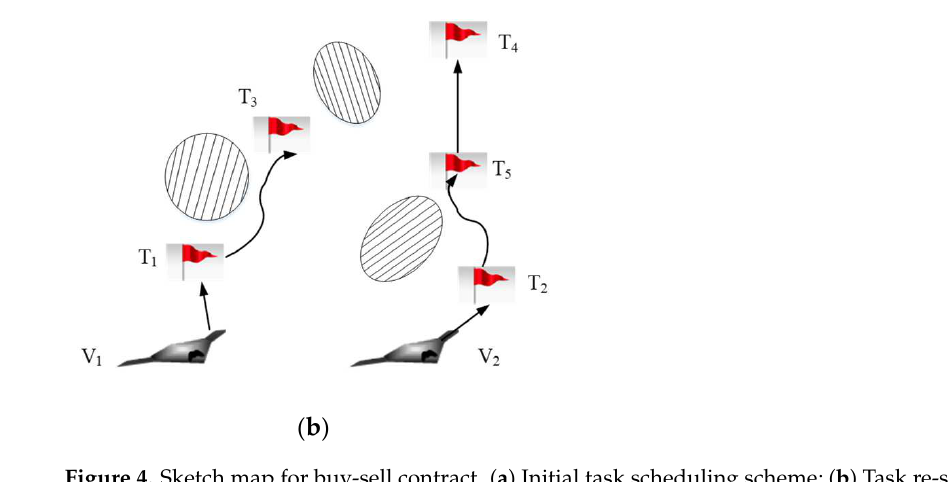
Figure 4. Sketch map for buy-sell contract. ( a ) Initial task scheduling scheme; ( b ) Task re-scheduling scheme.